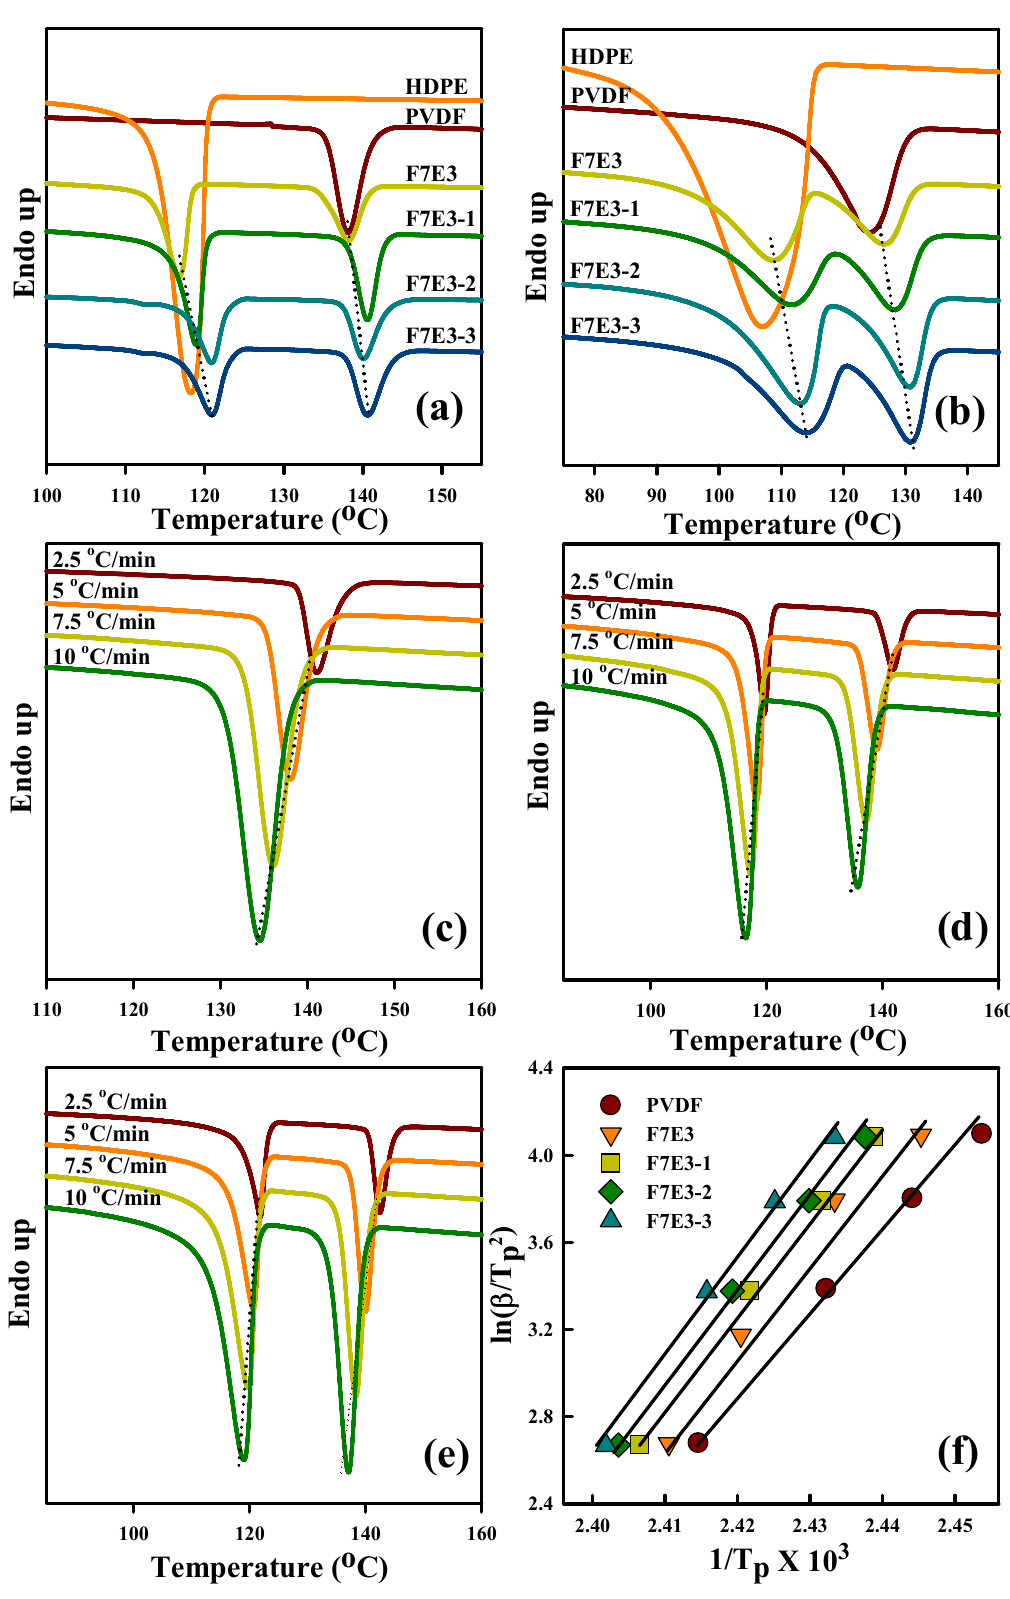
Figure 3. Differential scanning calorimeter (DSC) curves of the selected samples at ( a ) 5 ◦ C/min cooling from the melt, ( b ) 40 ◦ C/min cooling from the melt; DSC cooling curves of ( c ) PVDF, ( d ) F7E3, and ( e ) F7E3-3 at various rates; ( f ) Kissinger plots of selected samples for calculation of crystallization activation energy.